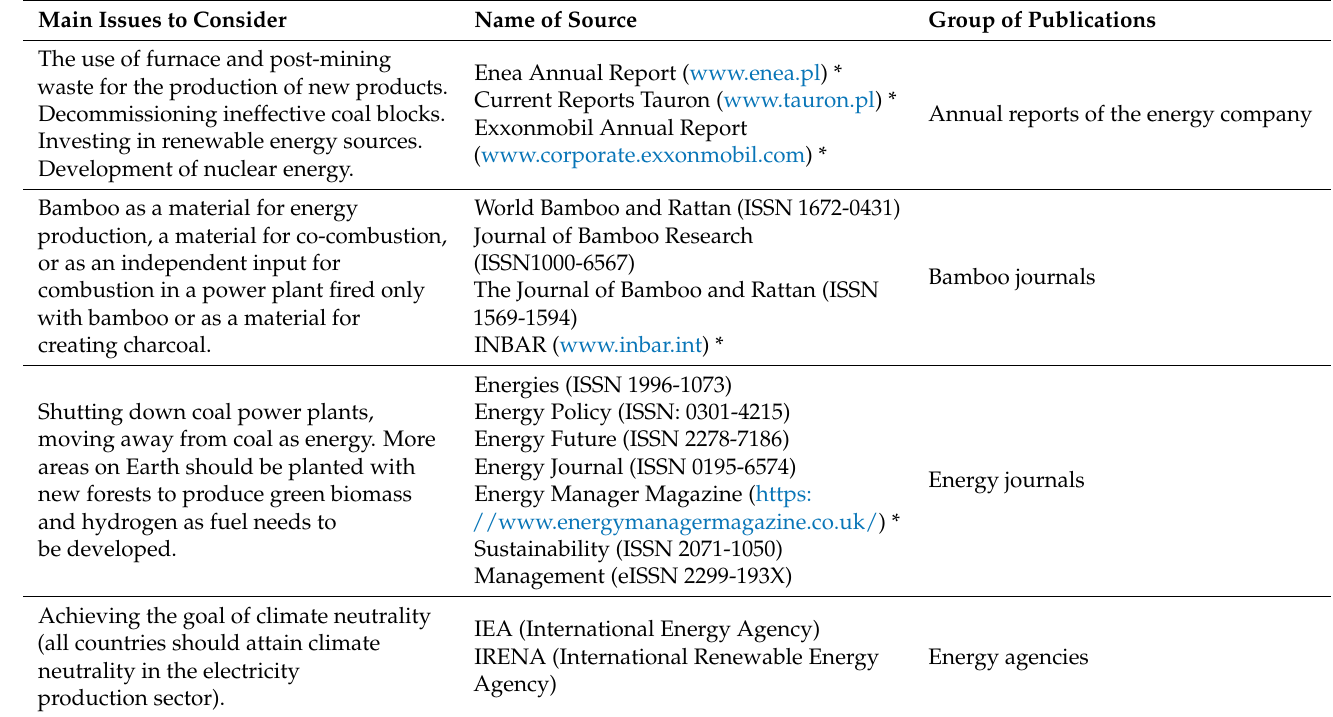
Table 1. List of sources constituting the basis of desk